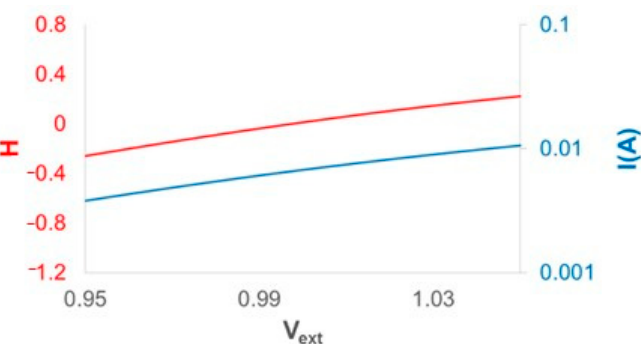
Figure 14. H function at a fixed frequency (left), close to transparency and laser current in logarithmic scale (right) as functions of the external voltage.